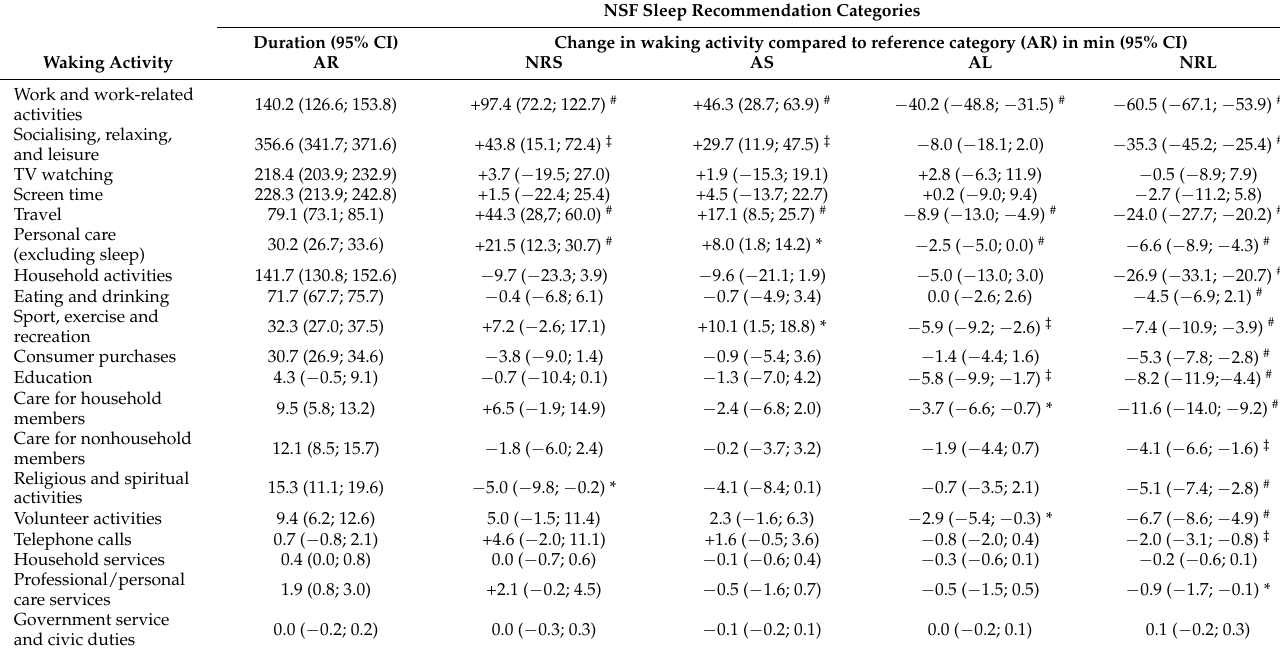
Table 8. Associations between daily time spent on waking activities (in minutes) and sleeping duration according to NSF guidelines at weekends ( N =